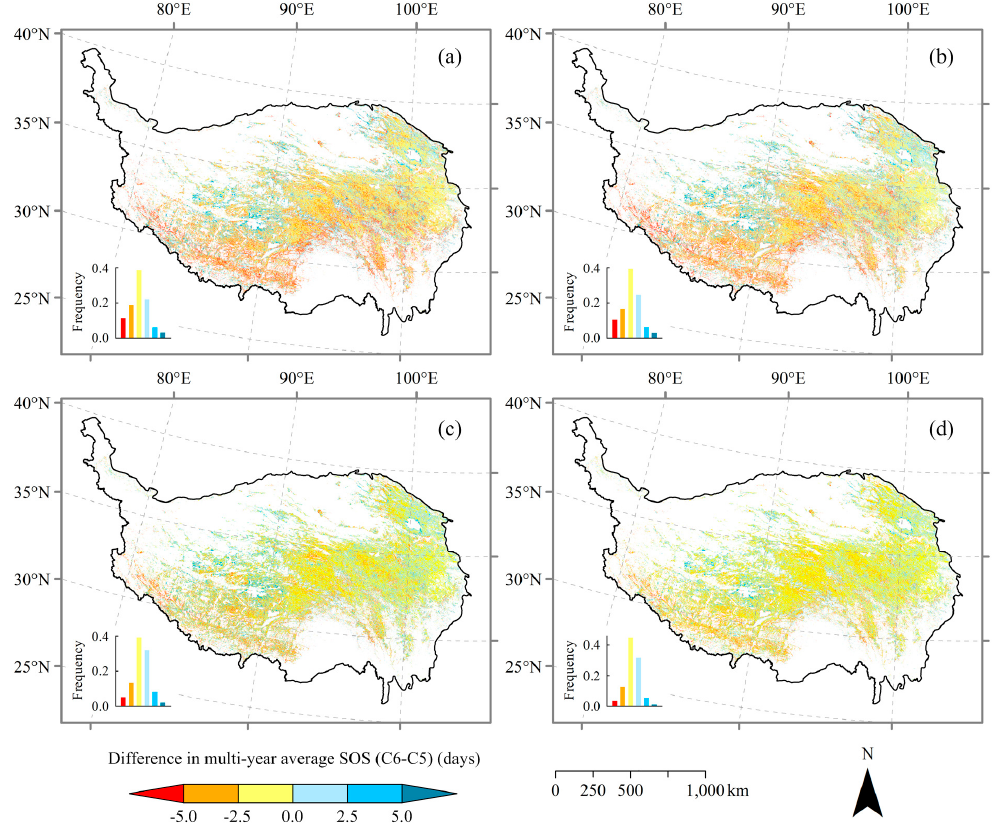
Figure 6. Spatial differences between the multi-year average SOS C6 and SOS C5 (C6–C5) for different methods: ( a ) Maximum Curvature Change (MCC); ( b ) Dynamic Threshold 0.2 (DT2); ( c ) Dynamic Threshold 0.5 (DT5); ( d ) Maximum Slope (MS).